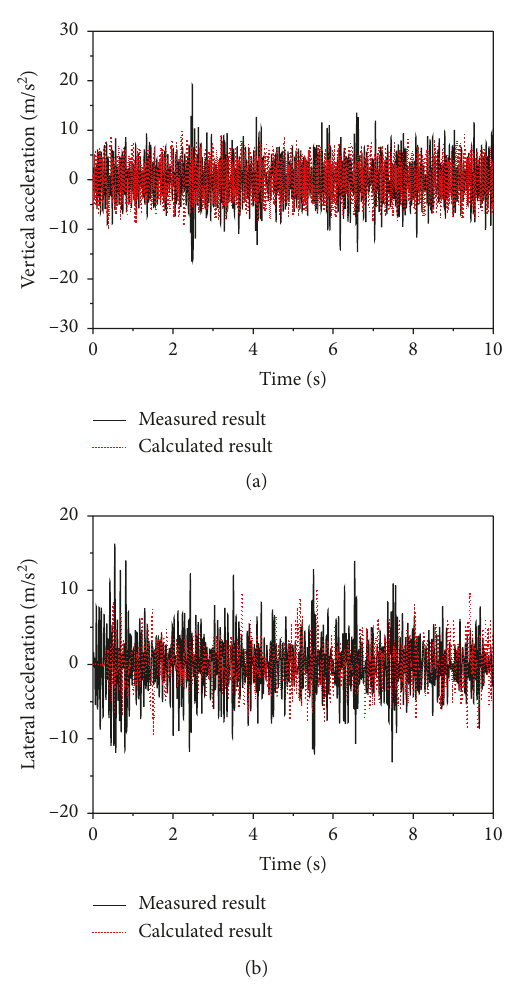
Figure 6: Comparison of measured and calculated result of bogie frame acceleration at a train speed of 350km/h: (a) time history of vertical acceleration; (b) lateral